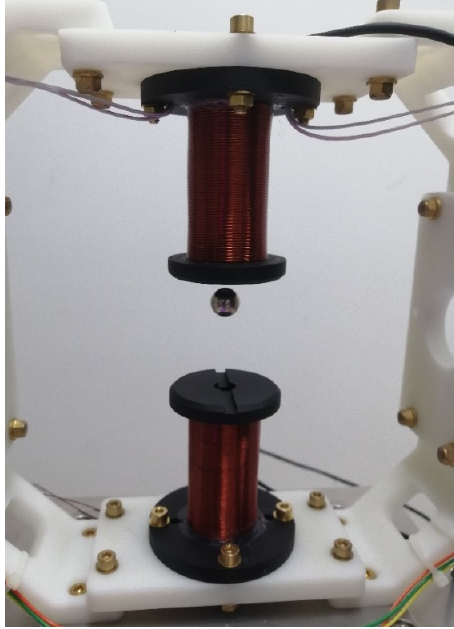
Figure 9. Permanent magnet ball stable levitation effect of the permanent magnet ball.